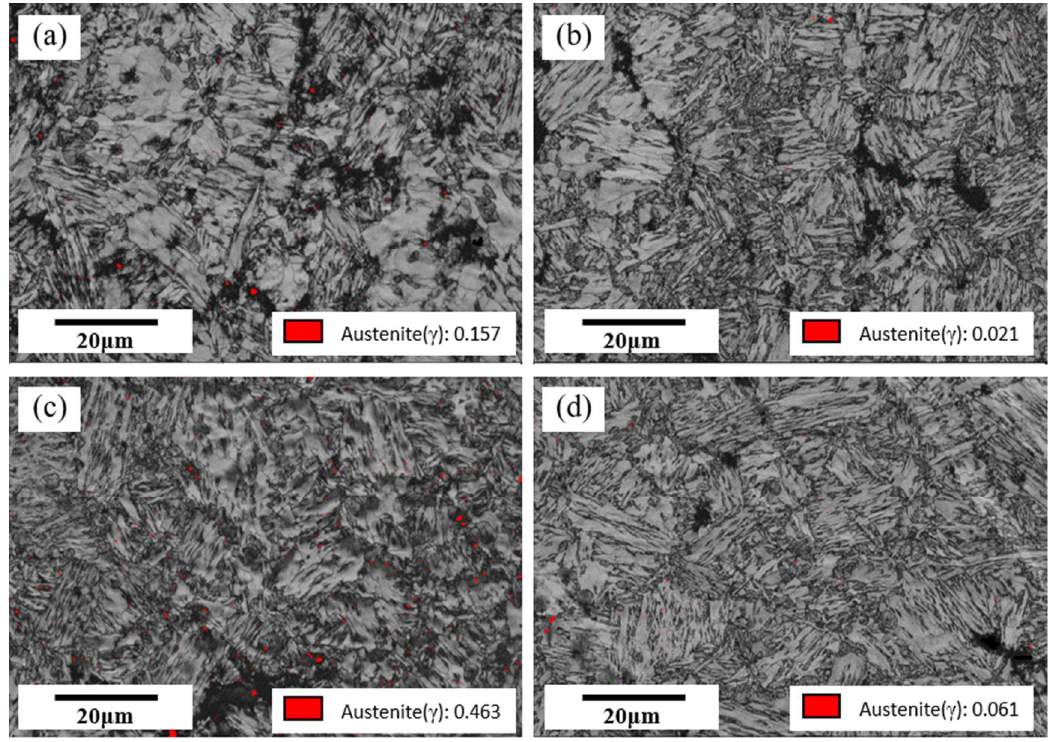
Figure 13. Image quality maps with austenite phase at different peak temperatures of ( a ) 800 °C; ( b ) 1150 °C; ( c ) 1250 °C; ( d ) 1350 °C.